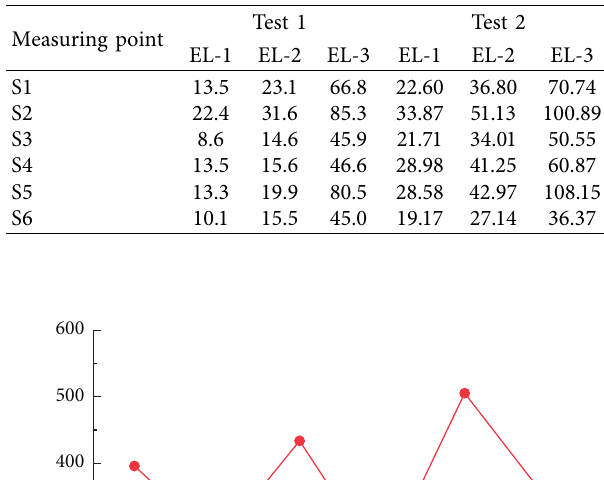
Table 5: Strain peak of structure under EL wave ( με ).